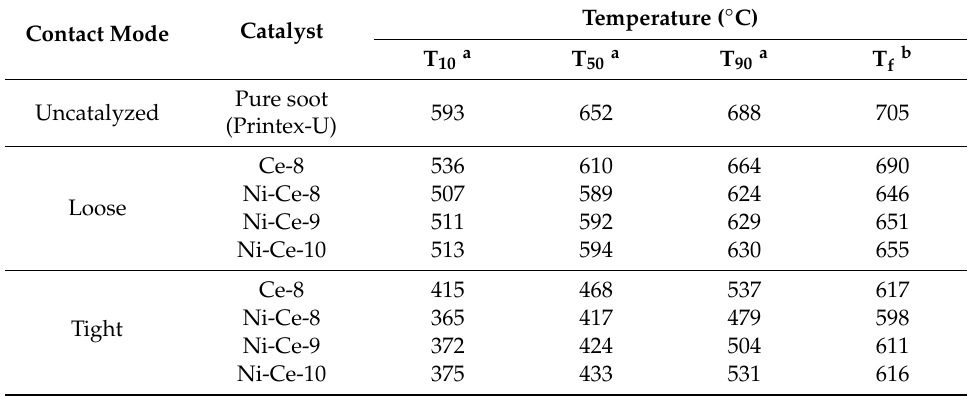
Figure 8. HAADF-STEM images of Ni-Ce-10 and EDS chemical maps of Ni and Ce.